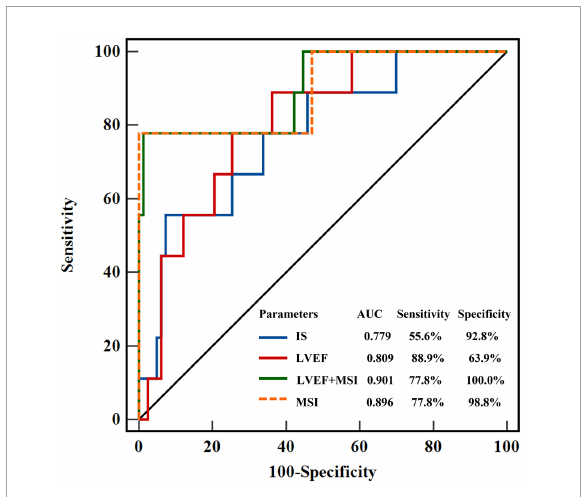
FIGURE5 Receiver-operating characteristic curves showed the prognostic value of LVEF, MSI, IS, and the combined model of LVEF + MSI. LVEF, left ventricular ejection fraction; MSI, myocardial salvage index, IS, infarct